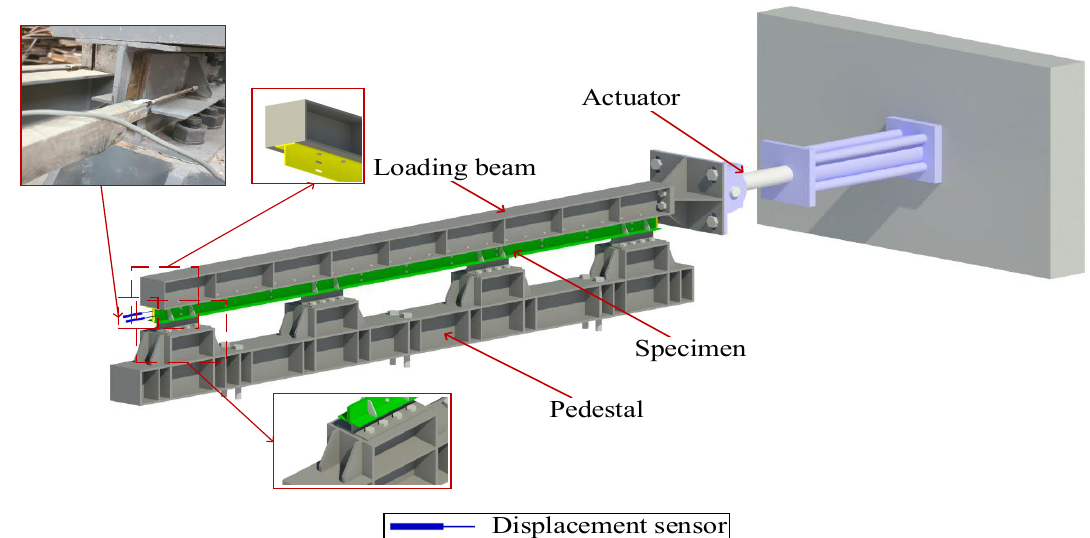
Figure 4. The loading device diagram of the friction energy dissipation composite chord.